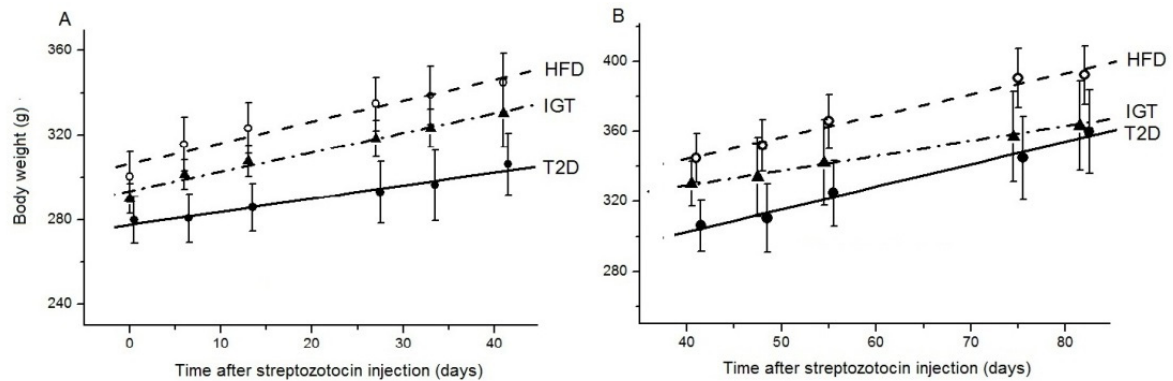
Figure 2. Changes in the body weight of rats in the groups with type 2 diabetes mellitus (T2D) and impaired glucose tolerance (IGT) after the administration of streptozotocin, and in the control group (HFD) after the administration of its solvent. ( A ) In the first 40 days; ( B ) in the second 40 days. ( A,B ) The T2D group ( n = 4), the IGT group ( n = 6) and the HFD group ( n = 6). Results are expressed as means ± the standard error of the mean (SEM). Straight lines are the regression lines.